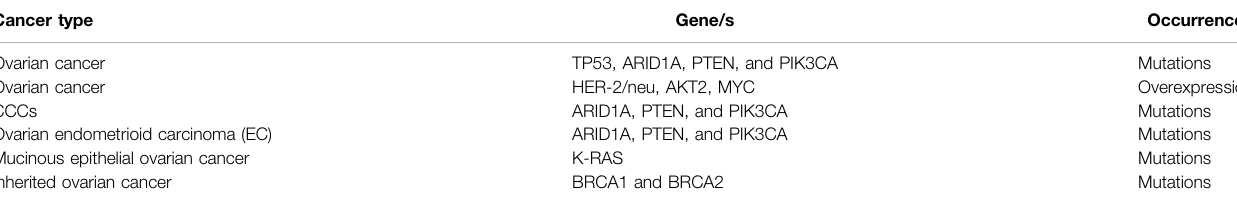
TABLE. 4 | Genes and their alterations in ovarian cancer and